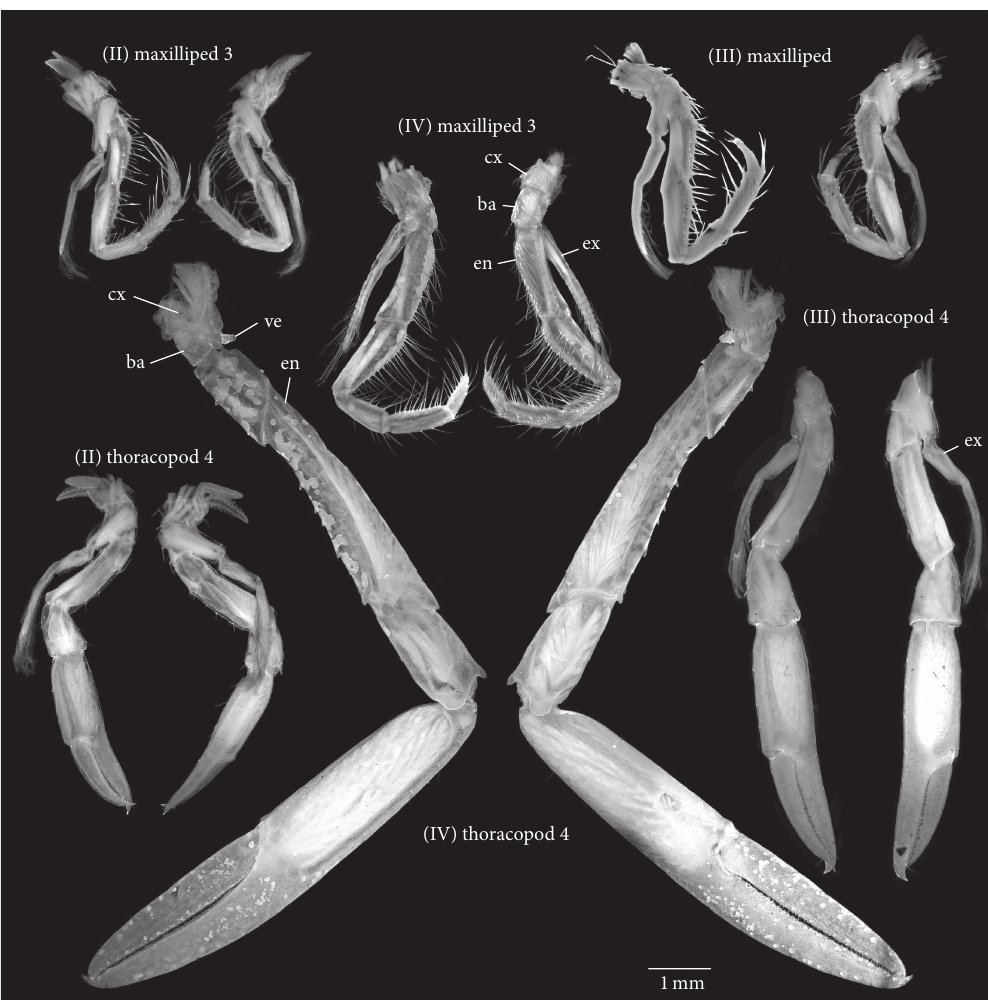
Figure 7: Maxilliped 3 and thoracopod 4 of larval stages (II) to (IV) of Homarus gammarus . Right appendage in anterior (left) and posterior (right)view,besides(II)maxilliped3,(III)maxilliped3,and(III)thoracopod4,whichareleftonesflipped.Labelingonlygiveninoneinstance due to the similarity of the structures throughout all stages. ba = basipod; cx = coxa; en = endopod; ex = exopod; ve = vestigial exopod.